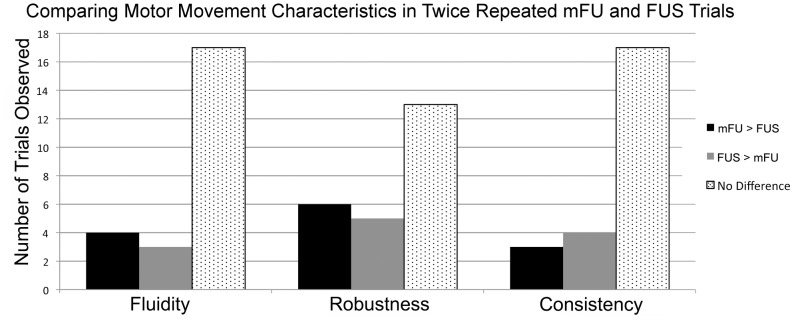
Qualities of movement induced by mFU versus FU applied successfully to the same region of the same mouse.Comparison between different measures of motion induced by each of mFU and FU applied to the same mice for cases where each protocol elicited a motor response twice in succession. Relative fluidity, robustness, and repetition of the movements are evaluated for 24 successful stimulations across three mice.